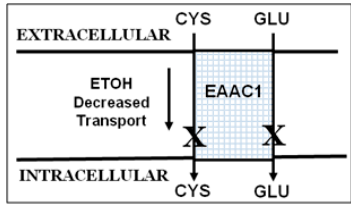
Figure 2. EAAC1—a neuronal transporter for cysteine (Cys) and glutamate (Glu).